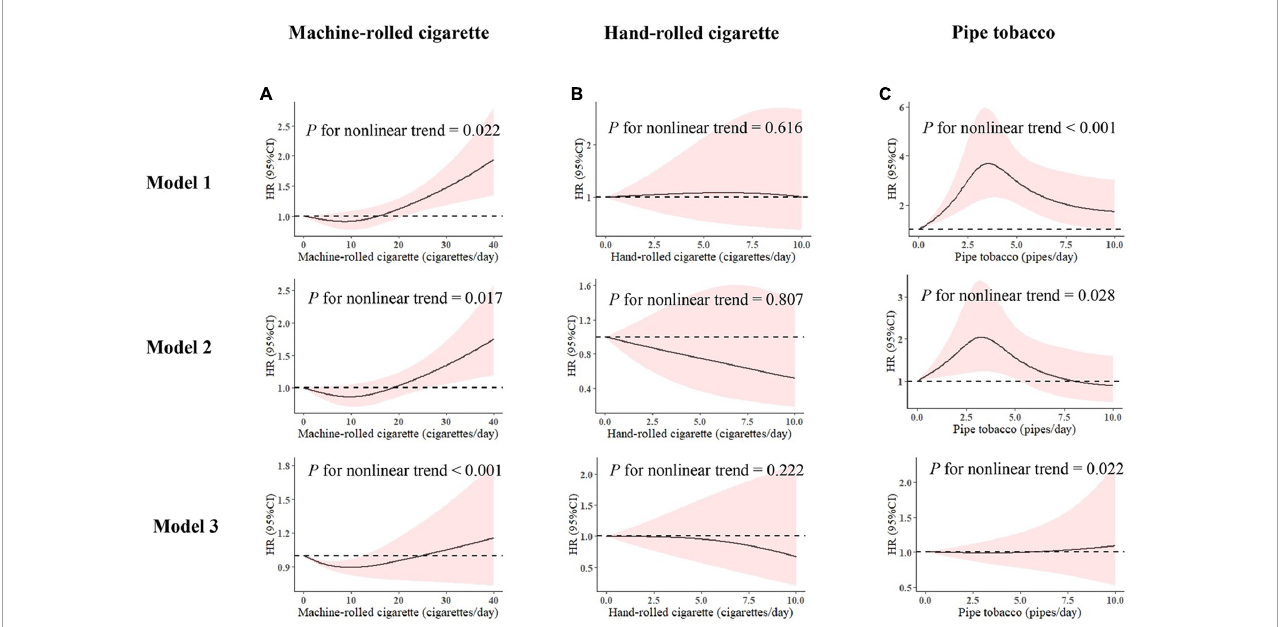
FIGURE1 Multivariable adjusted hazard ratios with 95% CI for the association of average daily consumption of (A) machine-rolled cigarettes, (B) hand-rolled cigarettes, and (C) pipe tobacco with 0 as the reference value. Model 1: no variables were adjusted. Model 2: adjusted for age (continuous variable) and sex. Model 3: model 2 plus area, ethnicity, marriage, occupation, alcohol use, physical activity, history of diabetes, SBP, total cholesterol (TC), triglycerides, HDL-C value, LDL-C value, and baseline body mass index (BMI) value. HR, hazard ratio; 95% CI, 95% confidence interval.